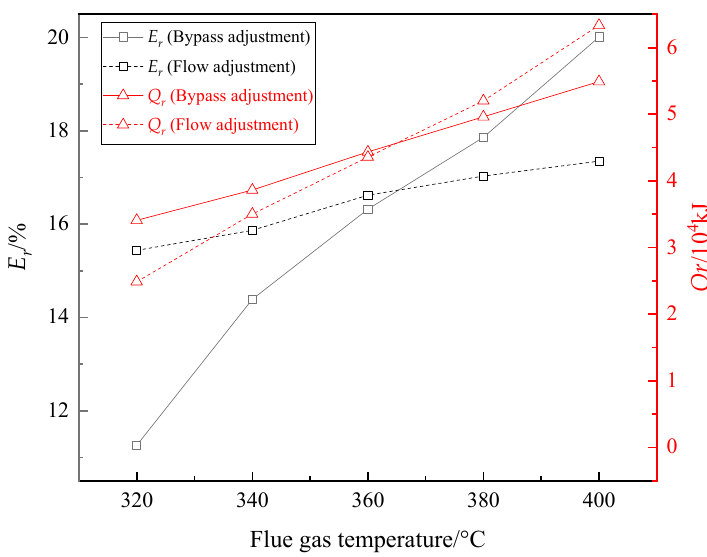
Figure 13. E r and Q r as flue gas temperature changed.